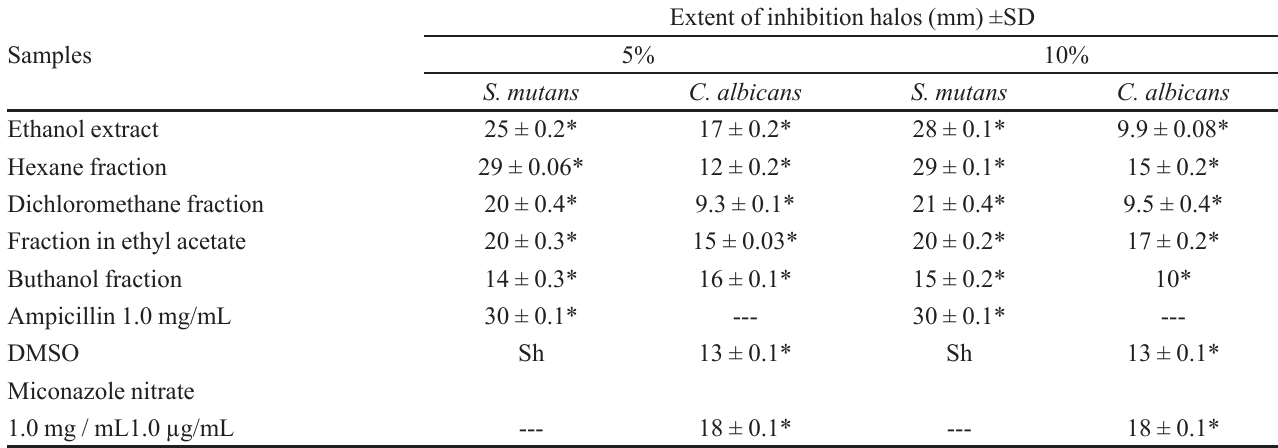
TABLE III - Results of extent of inhibition halos (mm), obtained from tests with Rosmarinus officinalis extracts; in concentrations of 5 to 10% tested against S. mutans ATCC 25175 and C. albicans ATCC 10231